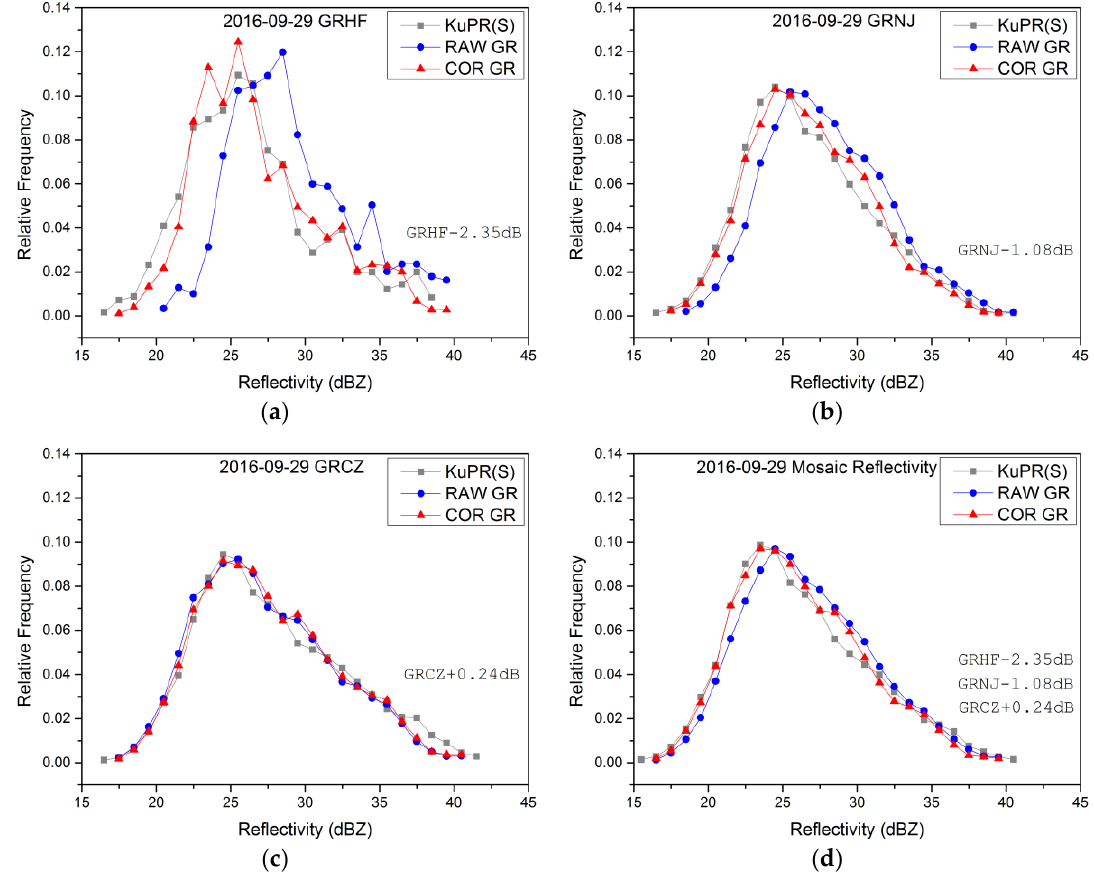
Figure 7. Raw and corrected reflectivity distribution for 29 September 2016 precipitation event. ( a ) GRHF. ( b ) GRNJ. ( c ) GRCZ. ( d ) Mosaic Reflectivity. KuPR(S) indicates KuPR reflectivities which were adjusted to S-Band by Radar Frequency Corrections.